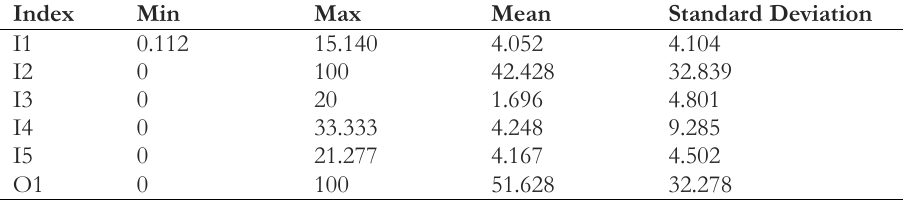
Table 3. Statistical information related to the data (2016).